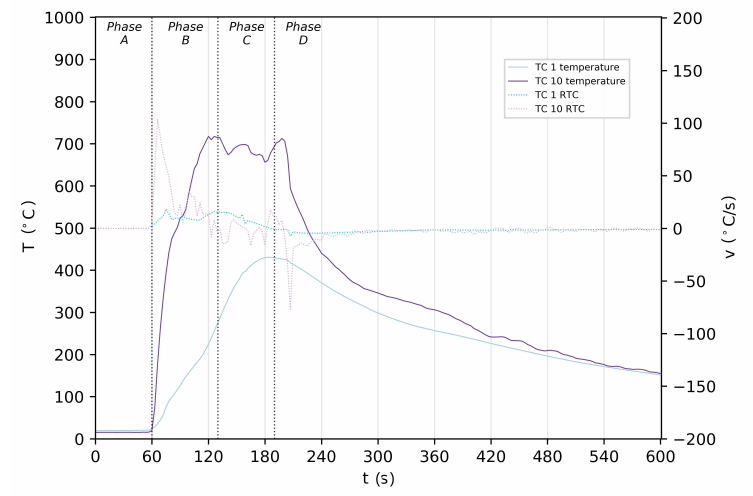
Figure 4. Temperature and RTC of thermocouples TC1 and TC10 in the first 600 s of the test. Phases A, B, C, and D according to Table 2 and Figure 1.